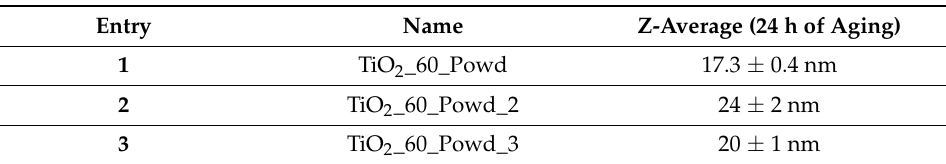
Table 3. DLS measurements for the reproducibility of TiO 2 _60_Powd after 24 h of aging. Errors reported in the table are expressed as standard deviation.